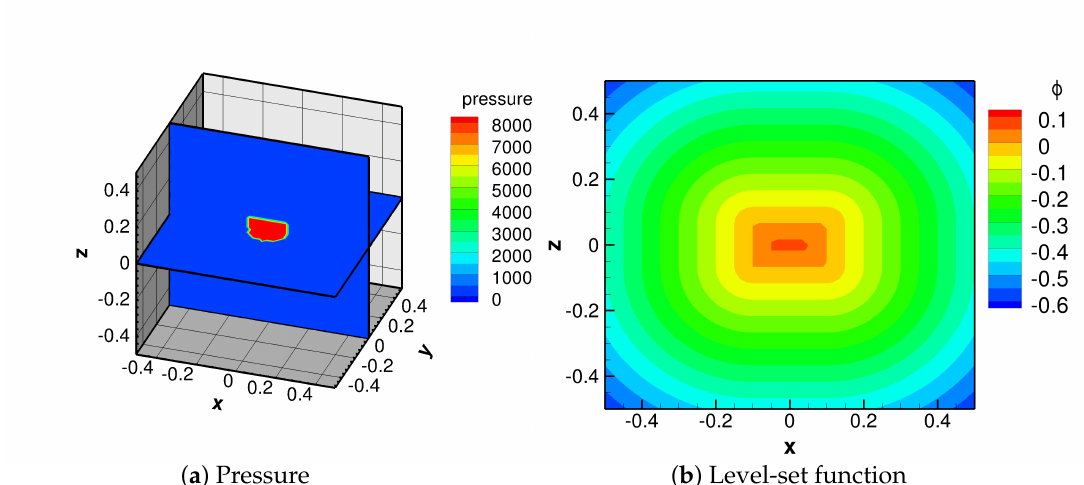
Figure 4. The initial setup of the UNDEX simulation with a high-pressure gas bubble of a cylindrical shape. The configurations of the figure are similar to Figure